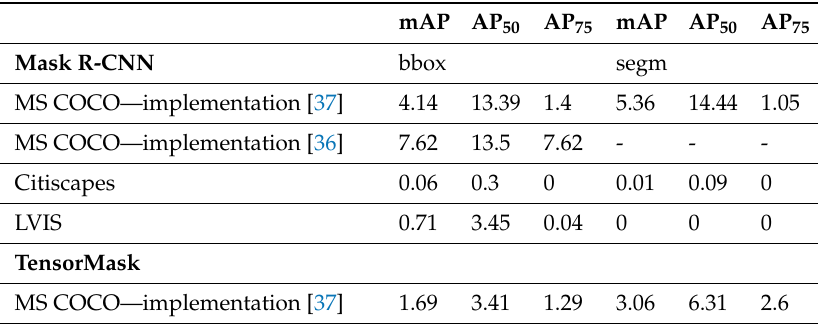
Table 6. Segmentation results for commonly available